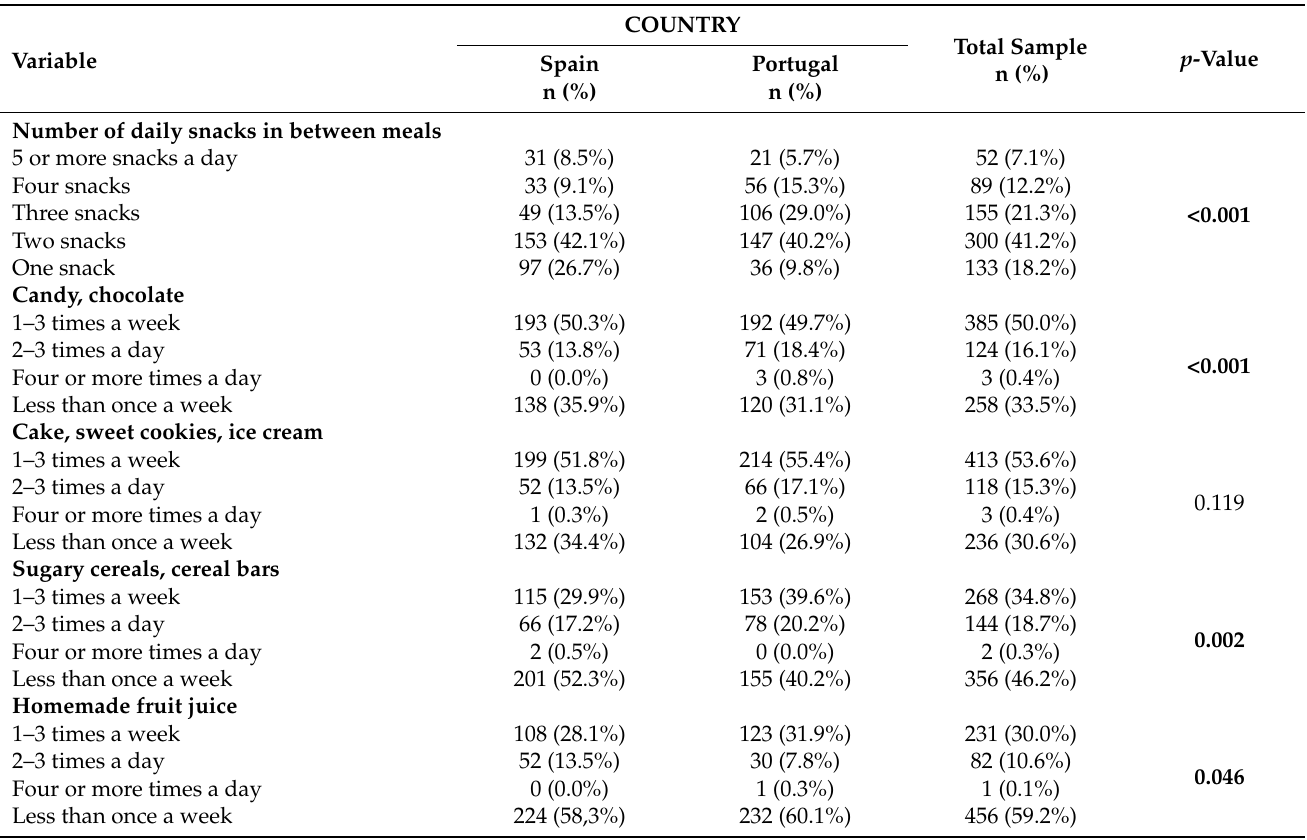
Table 2. Dietary habits during the lockdown: frequency of snacks in between meals and types of foods and drinks consumed during